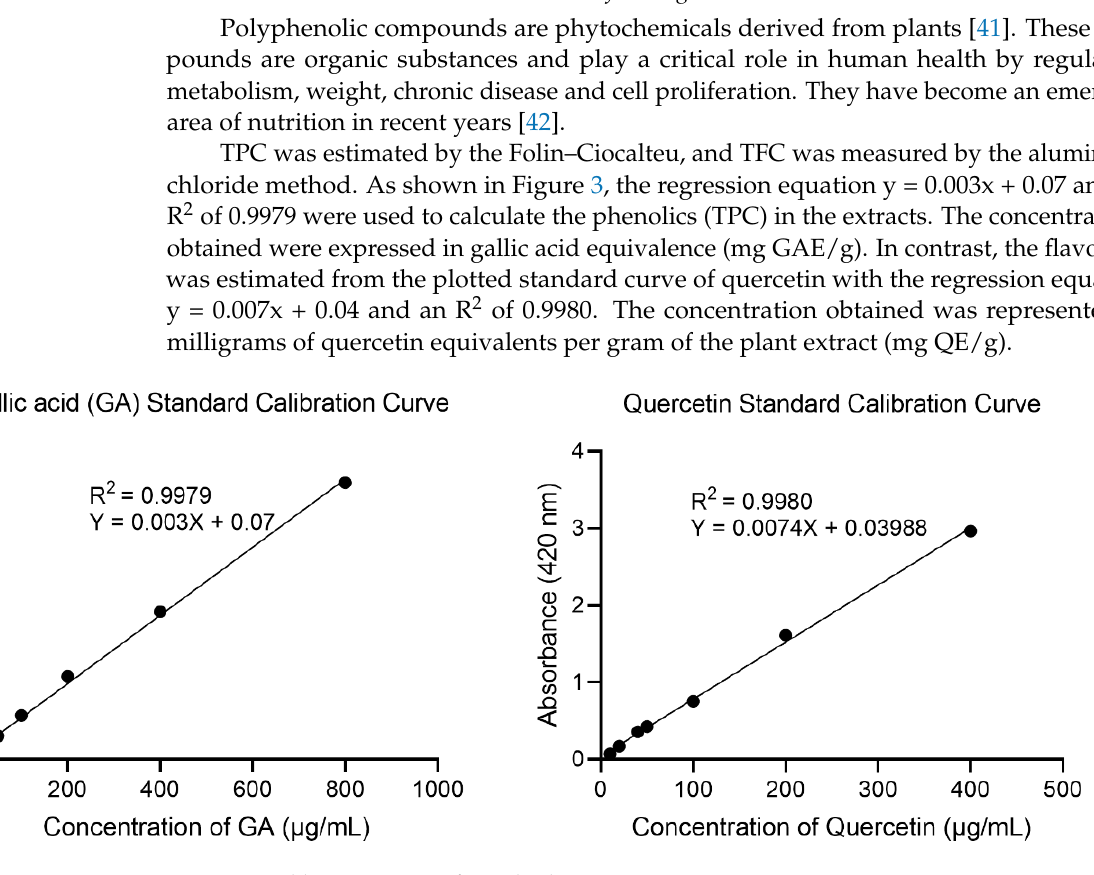
Figure 3. Calibration curve of standards.